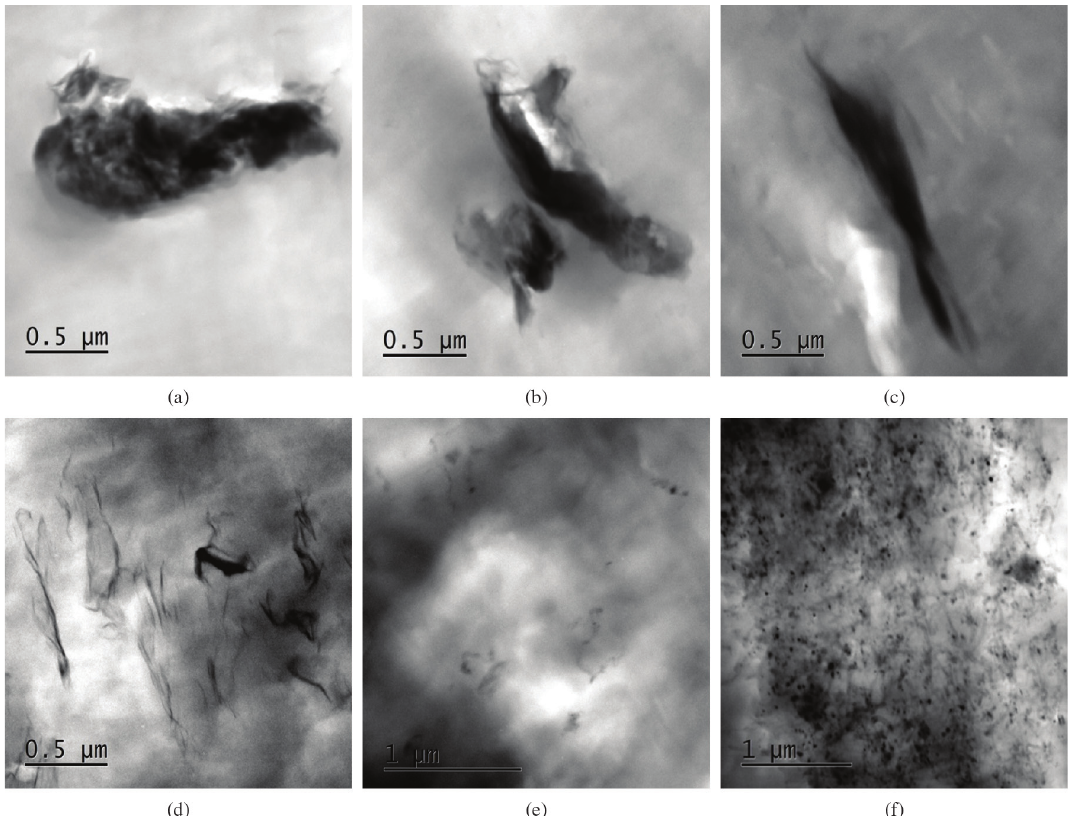
Figure 1. TEM micrographs of (a) PENam; (b) PENas; (c) PE30Bm; (d) PE30Bs; (e) PENCm; (f)